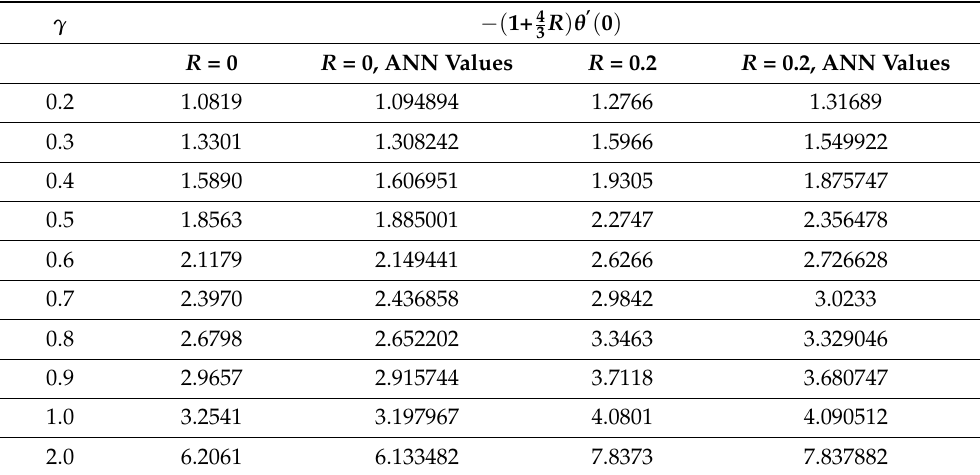
Table 11. Impact of curvature parameter on Nusselt number for non-radiative and radiative flow fields.